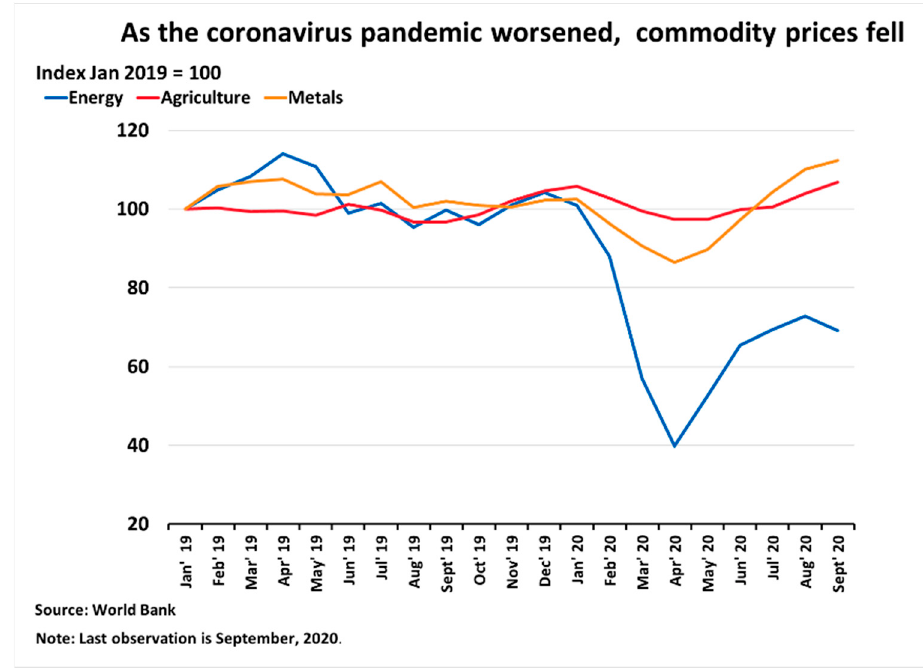
Figure 2. Drop in commodity prices due to COVID-19, the energy sector being the most affected. Adapted from World Bank [9].